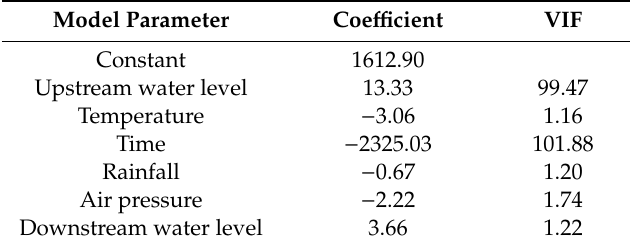
Table 1. Parameter estimation of the multiple linear regression